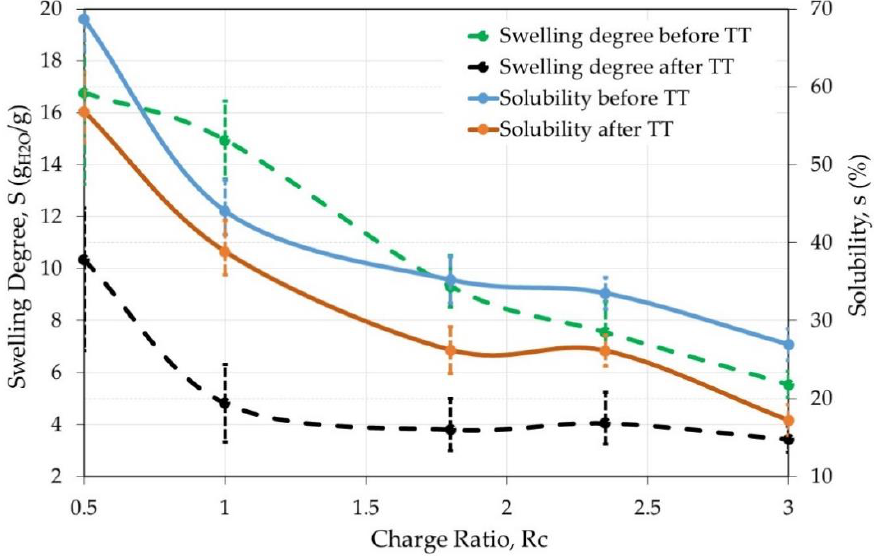
Figure 2. Solubility of PEC films at pH = 7.4 after thermal treatment as a function of charge ratio